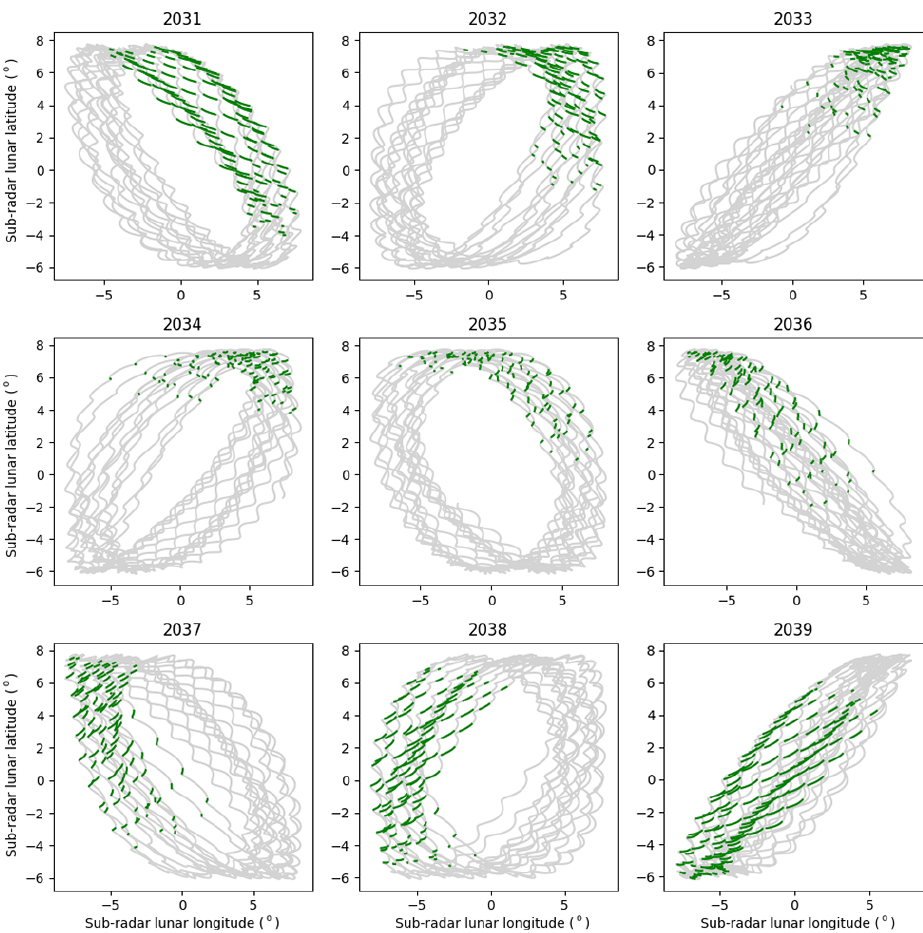
Figure 8. Lunar observation opportunities for 2031–2039. This figure is the same as Fig. 6 but extended further into the